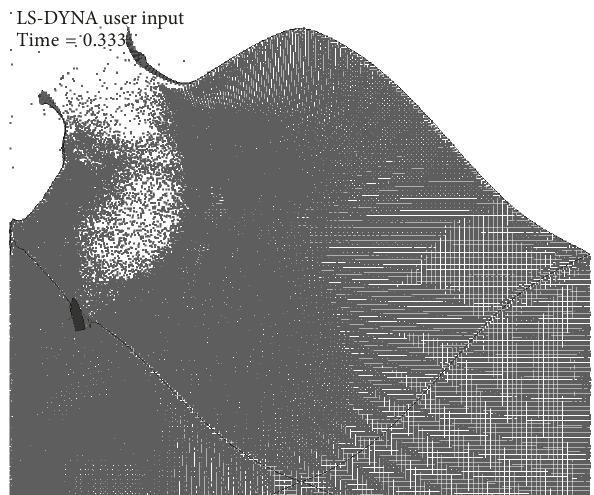
Figure22:PenetrationbyMCPBwhenaxisofprojectilewasnormal to the strip.